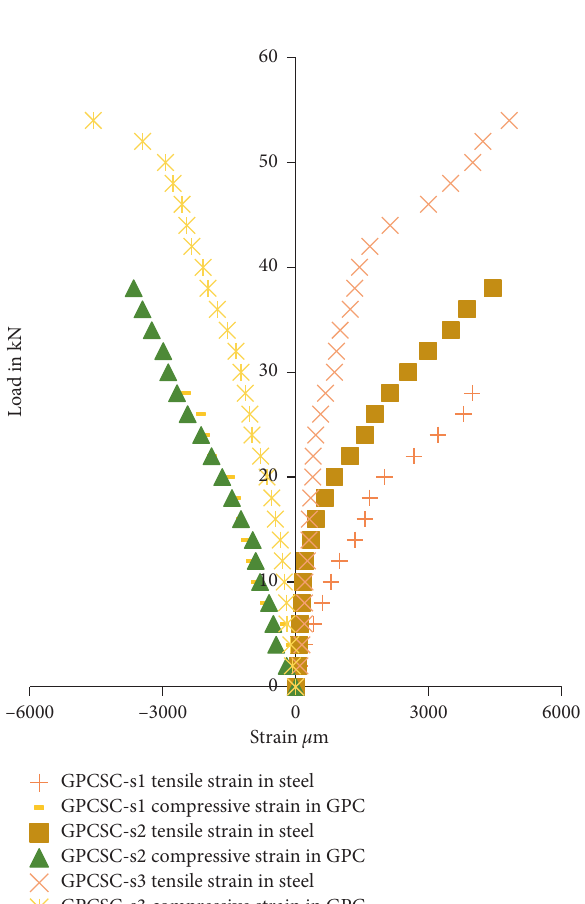
Figure 15: Load-strain behaviour of GPCSC